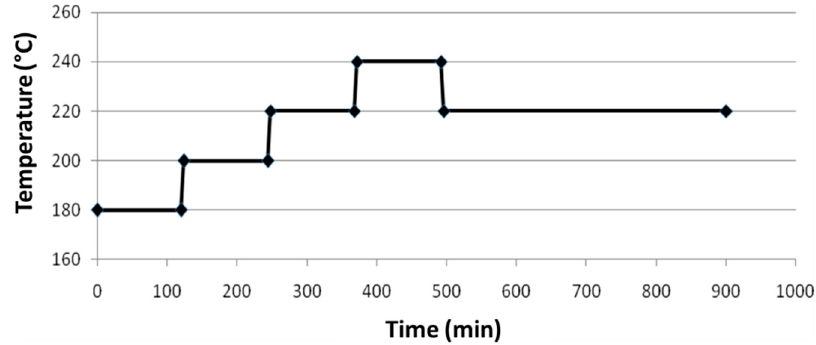
Figure 10. Installation Scheme.